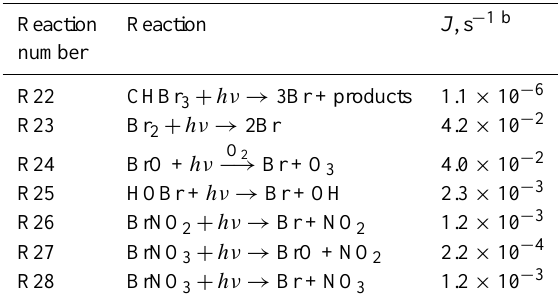
Table 2c. Tropospheric bromine chemistry in GEOS-Chem: three- body reactions a .